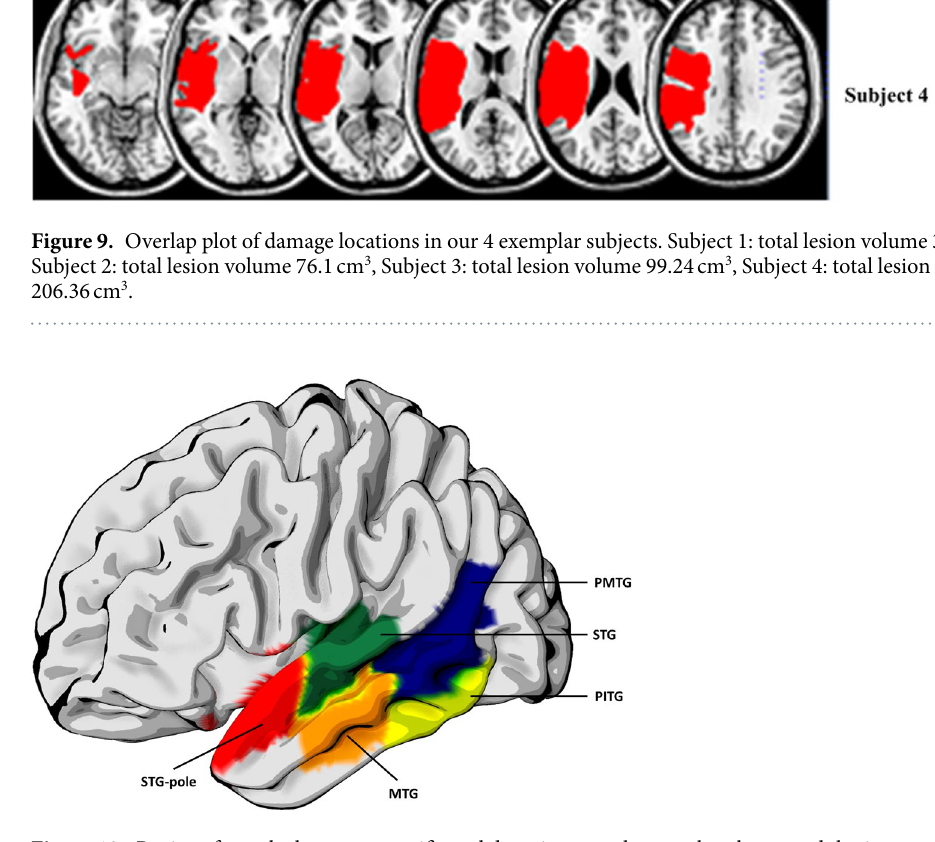
Figure 10. Regions from the language specific and domain general networks whose module sizes were significantly correlated with aphasia severity. STG-superior temporal gyrus (p = 0.0053), STG-pole -the pole of the superior temporal gyrus (0.0054), MTG- middle temporal gyrus (p = 0.0042), PMTG- posterior middle temporal gyrus (p = 0.0448), and PITG- posterior inferior temporal gyrus (p =